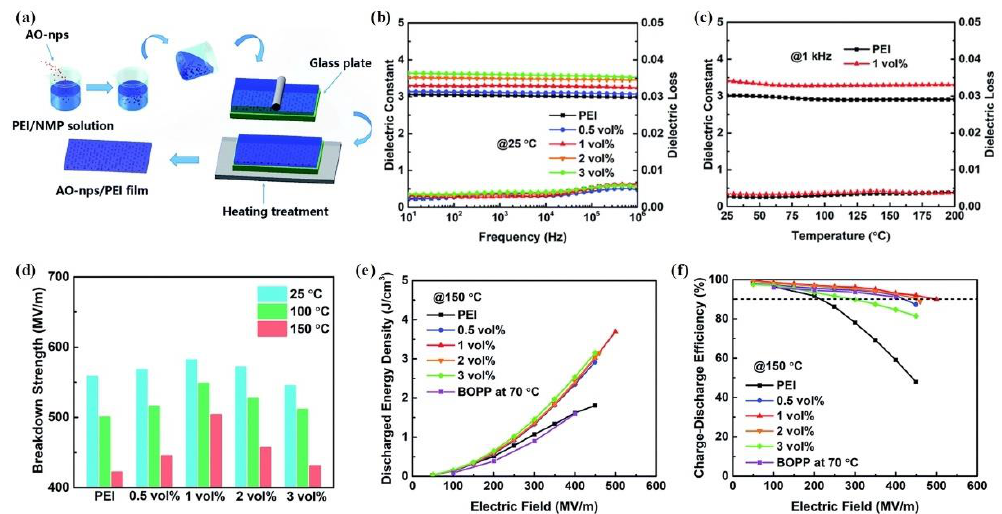
Figure 8. ( a ) Schematic illustration of the fabrication of the Al 2 O 3 /PEI nanocomposites. ( b ) The frequency-dependent dielectric constant of pristine PEI and Al 2 O 3 /PEI nanocomposites at 25 °C. ( c ) Temperature-dependent dielectric constant and loss of pristine PEI and 1 vol % Al 2 O 3 /PEI nanocomposite at 1 kHz. ( d ) Breakdown strength of pristine PEI and Al 2 O 3 /PEI nanocomposites at 25 °C, 100 °C, and 150 °C. ( e , f ) Discharge energy density and efficiency of pure PEI and Al 2 O 3 /PEI nanocomposites at 150 °C. Reproduced with permission from Ref. [76]. Copyright 2020, The Royal Society of Chemistry.